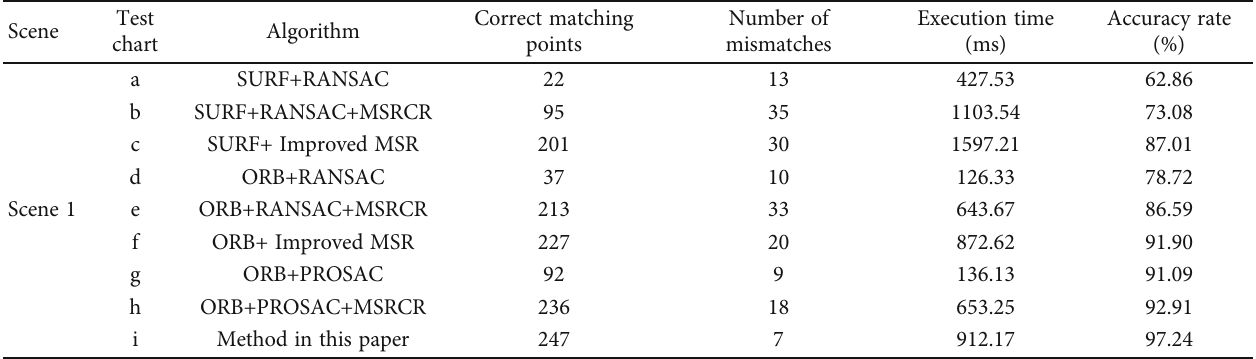
Table 1: Performance comparison of various algorithms in local scene of experiment 1.